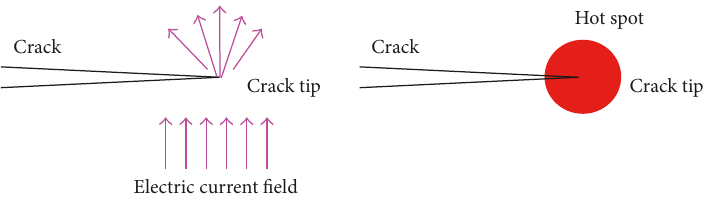
Figure 1: Electric current concentration and hot spot at crack tip. Table 1: Temperature-dependent physical properties of mild steel [9, 13].